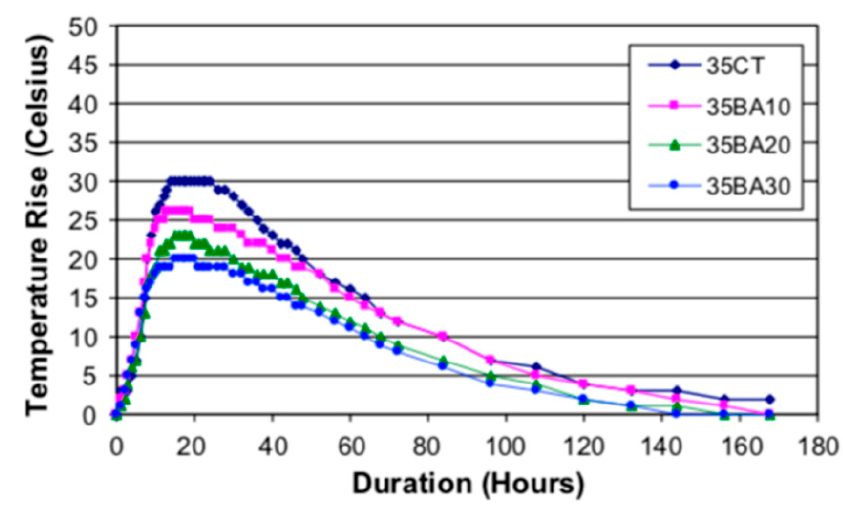
Figure 11. Semi-adiabatic temperature rise (°C) in concrete containing SBA as substitute [82].